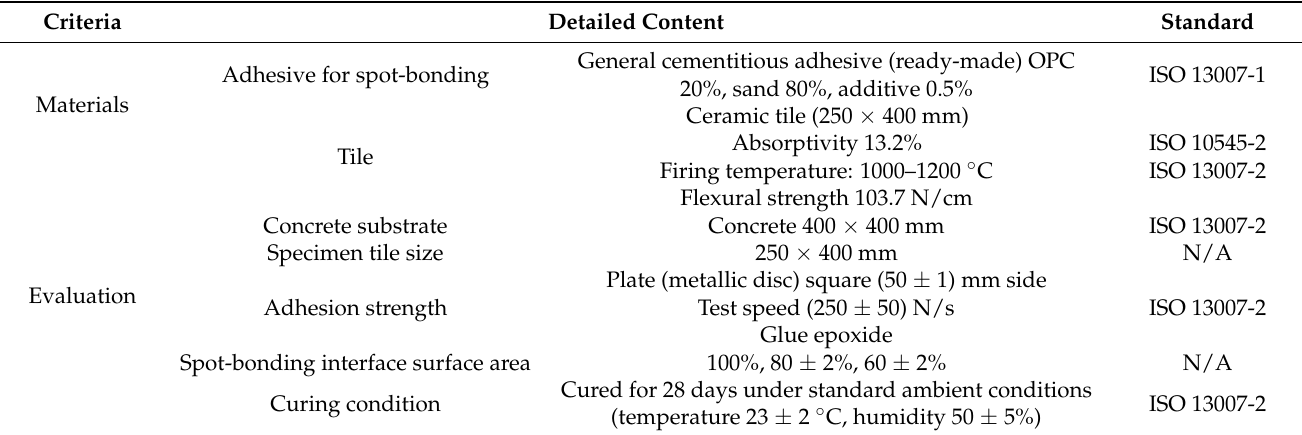
Table 3. Experimental scope summary.